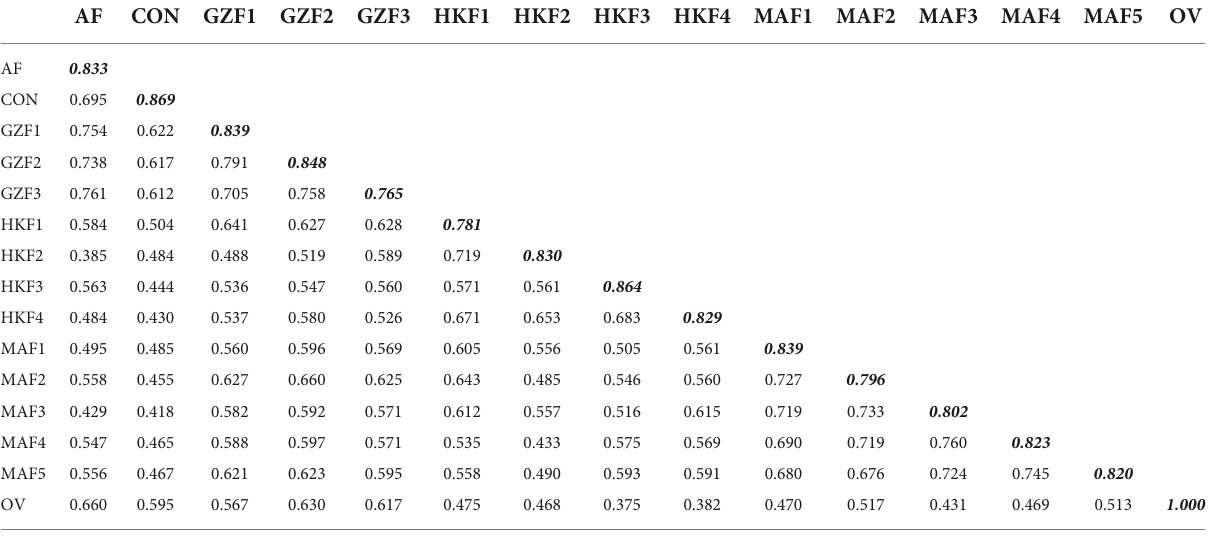
Fornell-Larcker